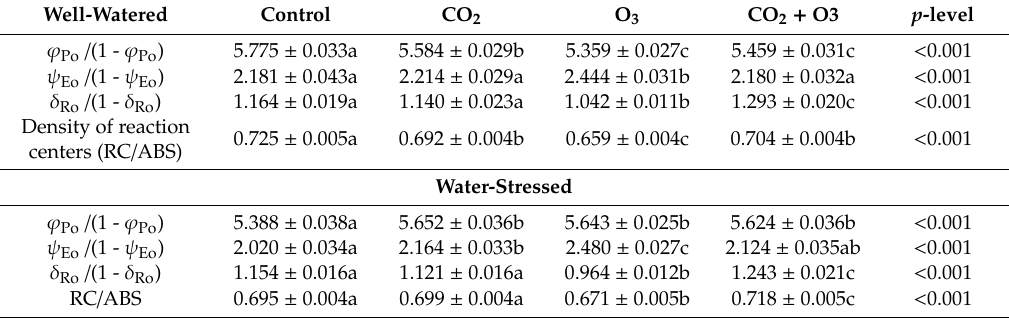
Table 1. The e ff ect of elevated CO 2 , O 3 and CO 2 + O 3 on the components of the PI total in canola plants under well-watered and water-stressed conditions. Values are means of weeks and SE (Standard Error). Di ff erent letters in the same row indicate statistically significant di ff erences between the treatments ( p <